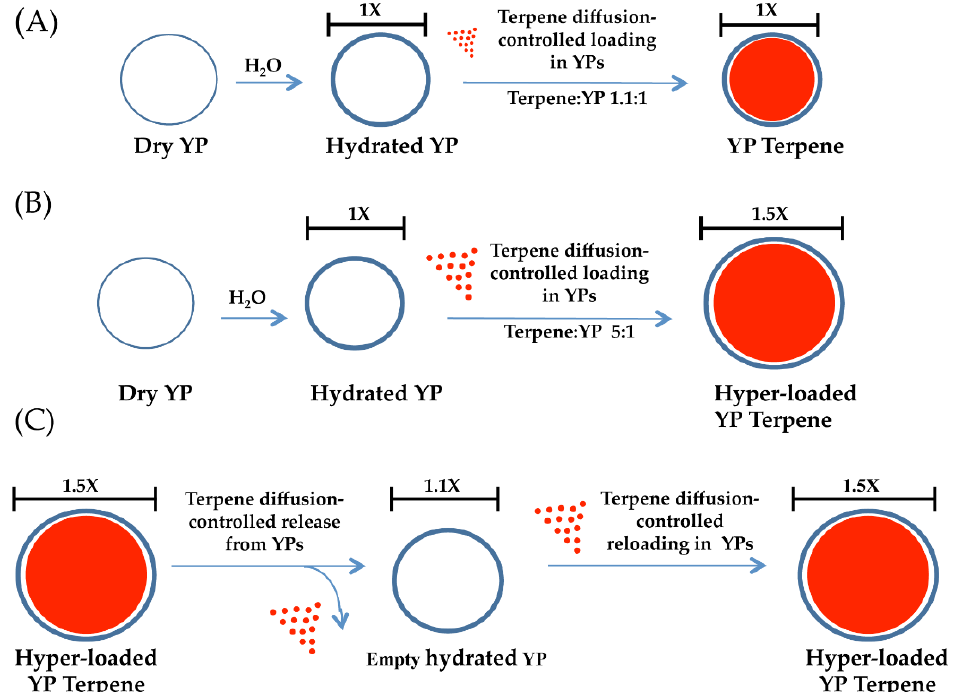
Figure 1. Schematics of diffusion-controlled terpene loading in YPs at terpene: YP weight ratios of ( A ) 1.1:1 and ( B ) 5:1, showing an increase in yeast particle diameter for hyper-loaded samples.